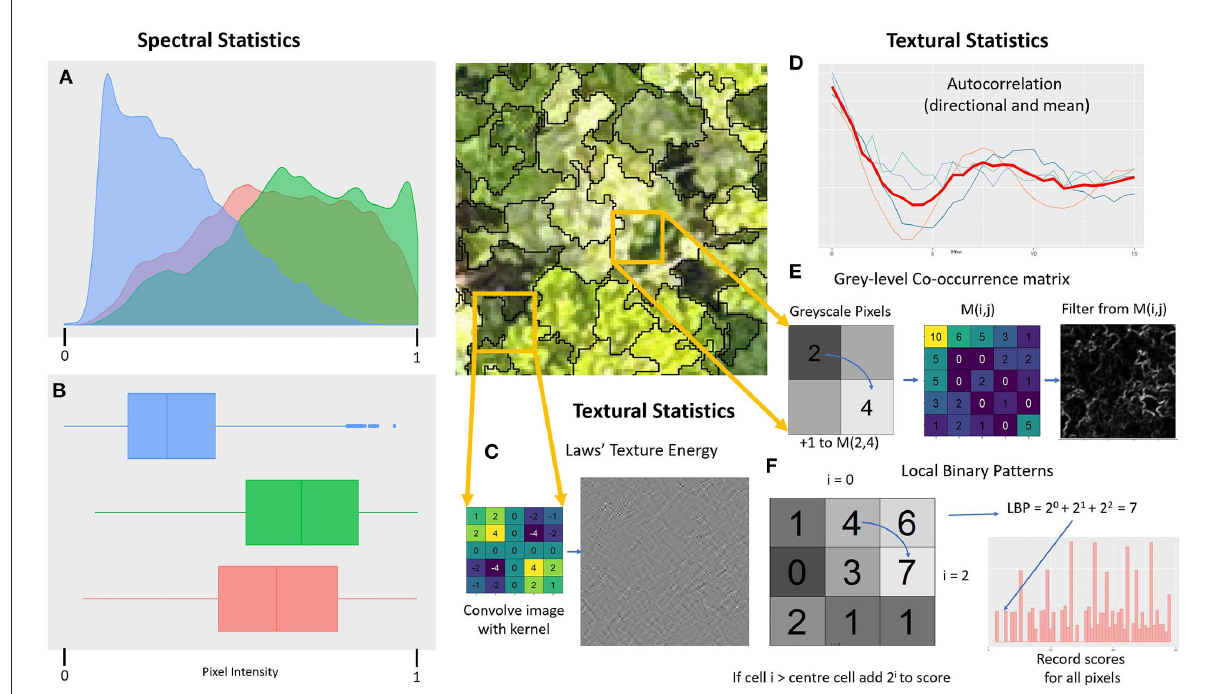
FIGURE6 Illustration of the key features used in this work. On the left are example visualizations of distribution for parametric (A) and non-parametric statistics (B) for RGB pixels in the central image. (C) Is an example of a filter used for Laws textural features, with the E5E5 kernel for detecting edges. (D) Shows autocorrelation scores in four directions spaced by 45 ◦ with average score overlaid. (E) Is an example calculation of a gray-level co-occurrence matrix and the filter given by the dissimilarity measure in a local 7 × 7 neighborhood. (F) Is an example of computing a Local Binary Pattern, with a histogram of occurrences of each motif score across the inset imagery.